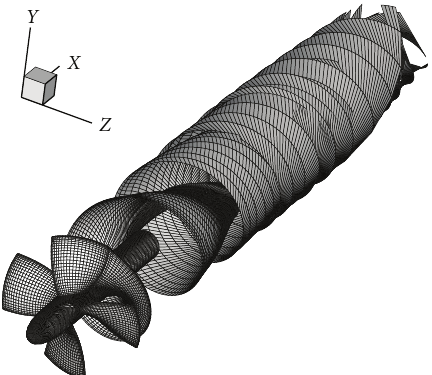
Figure 6: Panel arrangement for propeller Ka4-70 at J = 0 . 5 for the wake alignment model with empirical contraction. Note that the only one blade wake grid (400 × 25) is